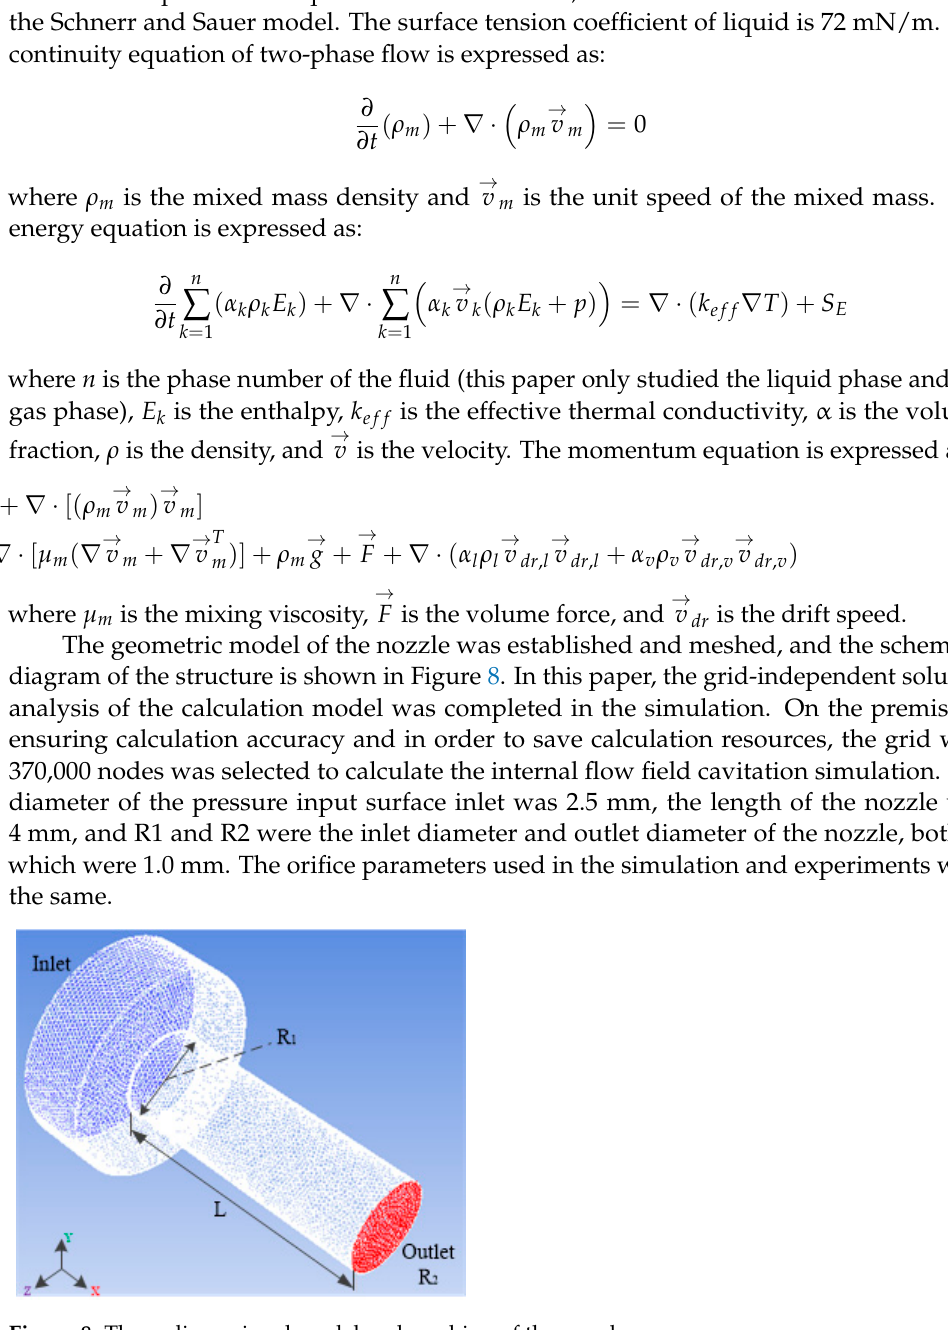
Figure 8. Three-dimensional model and meshing of the nozzle.